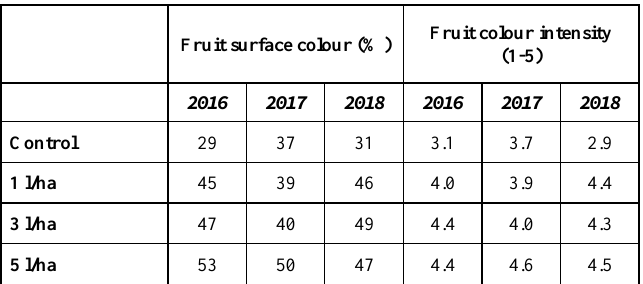
Table 5 . Fruit surface colour and fruit colour intensity (Debrecen – Pallag, 2016-2018) Fruit surface colour (%)